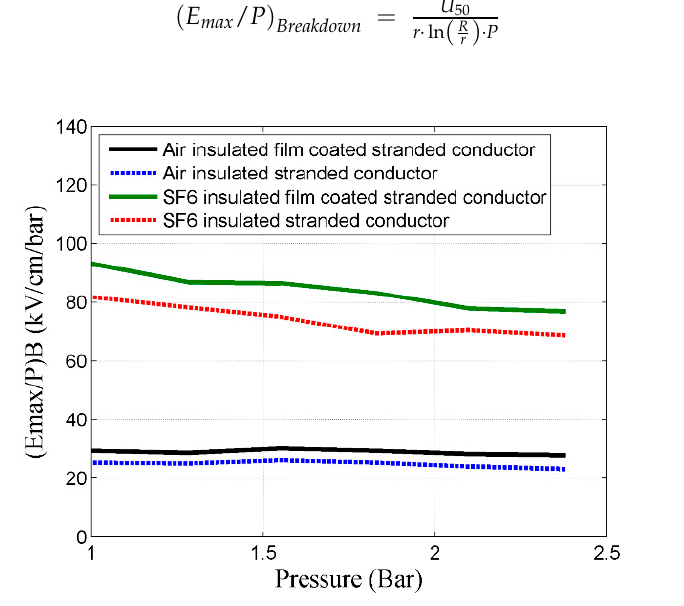
Figure 23. Field strength comparison in fabricated FGIL models regarding air and SF 6 at different gas pressures.